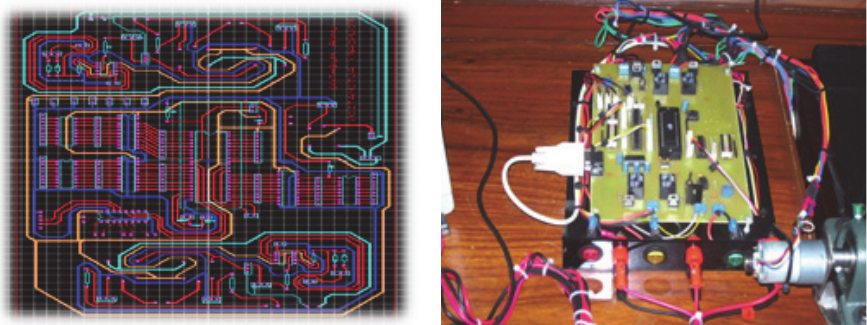
Figure 13: Proteus PCB layout fabricated electronics hardware.